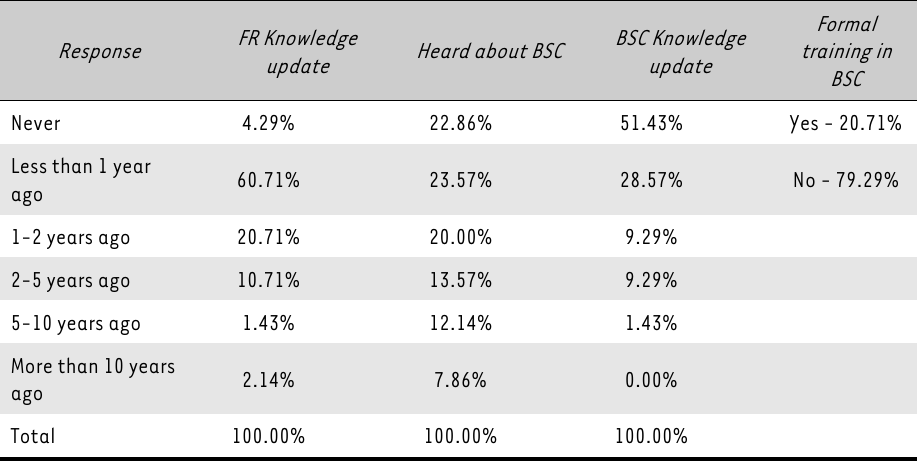
TABLE 1: Last time knowledge on Financial Ratios (FR) and BSC was updated Formal FR Knowledge BSC Knowledge Response Heard about BSC training in update update BSC 4.29% 22.86% 51.43% Yes -